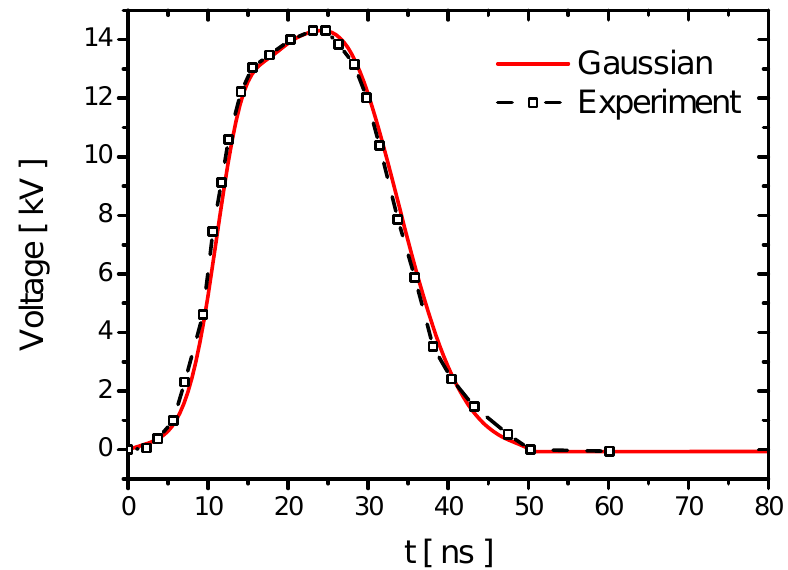
Figure 1. Waveforms of the experiment voltage and the fitted Gaussian voltage. Peak voltage U peak = 14 kV, rising time τ rise = 25 ns and pulse duration τ pulse = 50